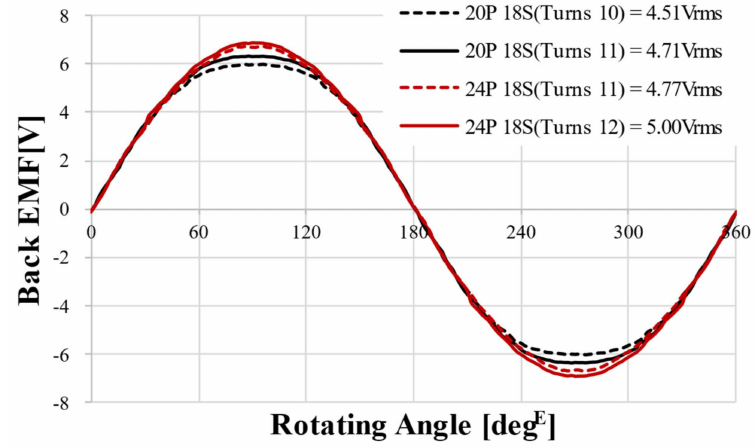
Figure 20. Back EMF FEA results of optimization model @1000